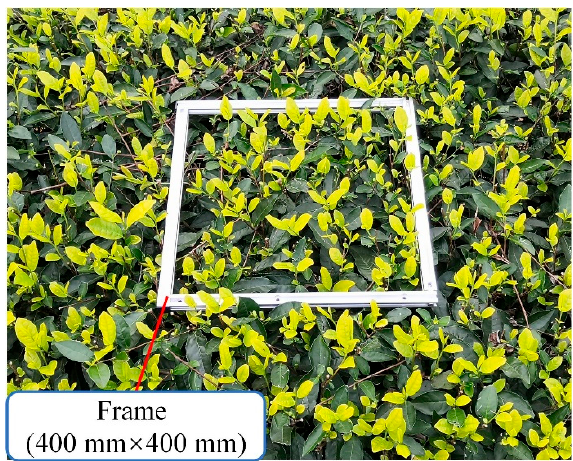
Figure 4. Measurement of average growth region area.